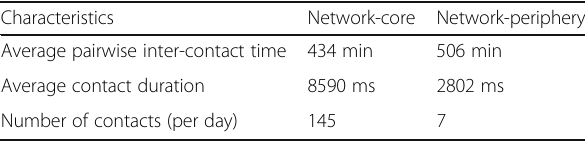
Table 2 Characteristics of the two regions in the network